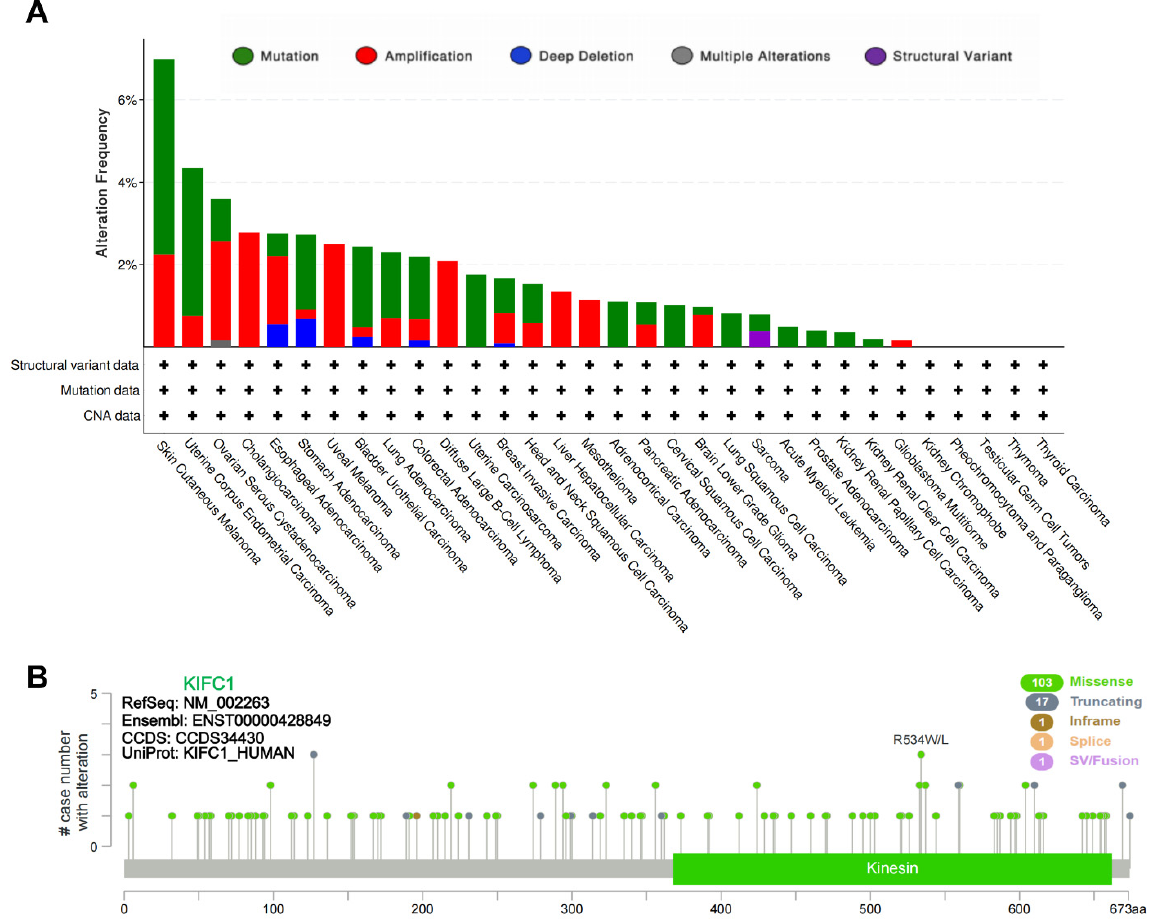
Figure 1. Genetic alterations of KIFC1 in different tumors of TCGA database. ( A ) Alteration frequen- cies with mutation types. ( B ) The mutation sites and case numbers of KIFC1 genetic alterations. CNA: copy number alteration; SV: structural variation.